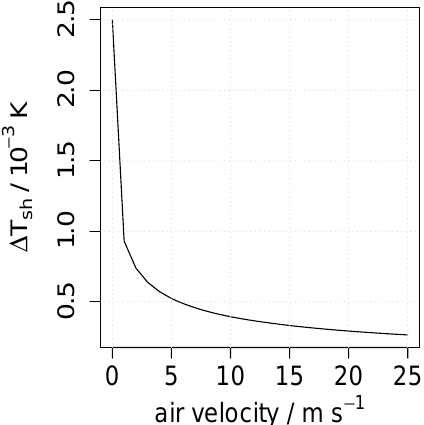
Fig. 4. Theoretically calculated self-heating for a 25µm platinum wire with the designed measuring